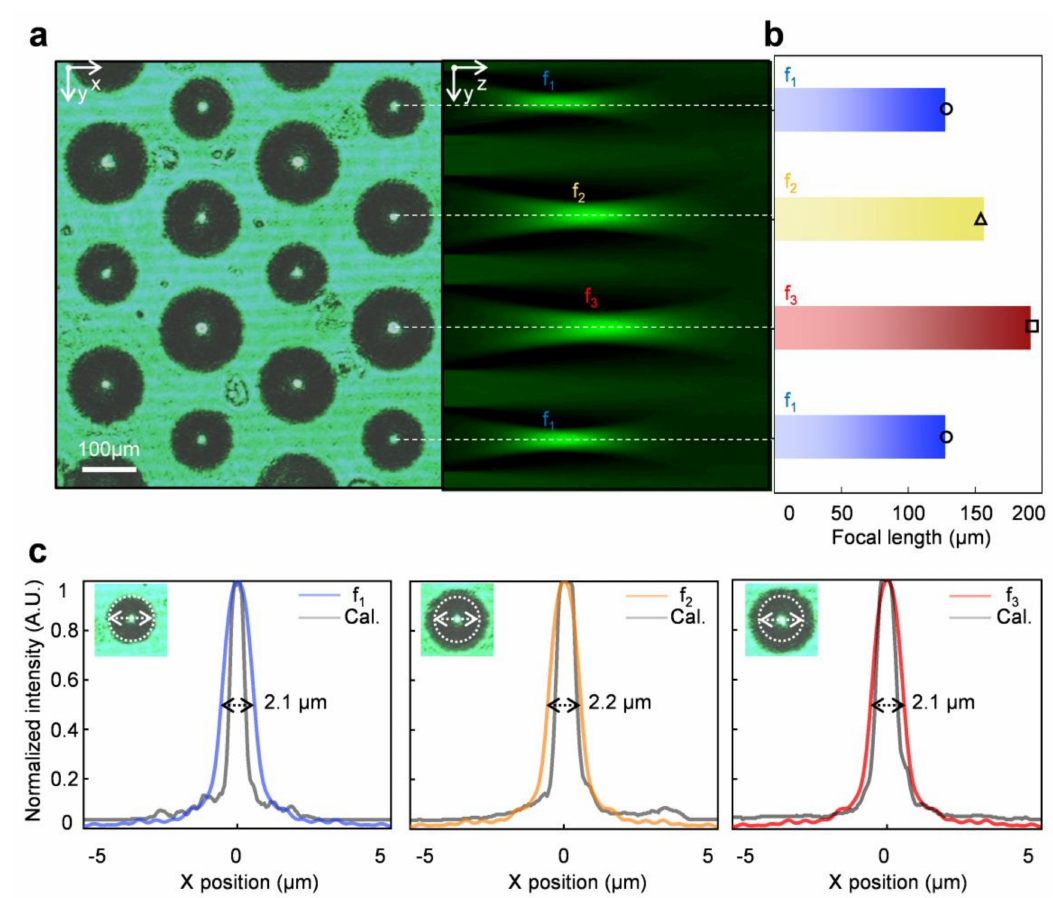
Figure 3. ( a ) Three experimentally measured focal lengths of Mf-MLAs through the stacked optical microscope images (top view; left, cross-sectional view; right). The pitch between microlenses is 200 µ m. ( b ) Graph of measured (bars) and calculated (symbols) focal lengths at each microlens with three di ff erent focal lengths. ( c ) Intensity profiles along the X-axis of the foci depending on the lens type of the fabricated